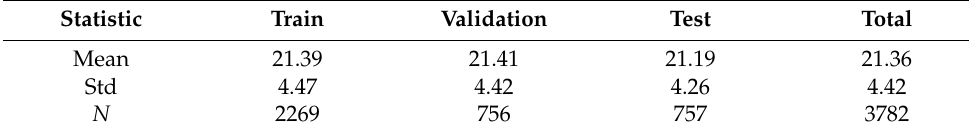
Table 1. Summary statistics of PigBT according to the back-fat thickness (mm).